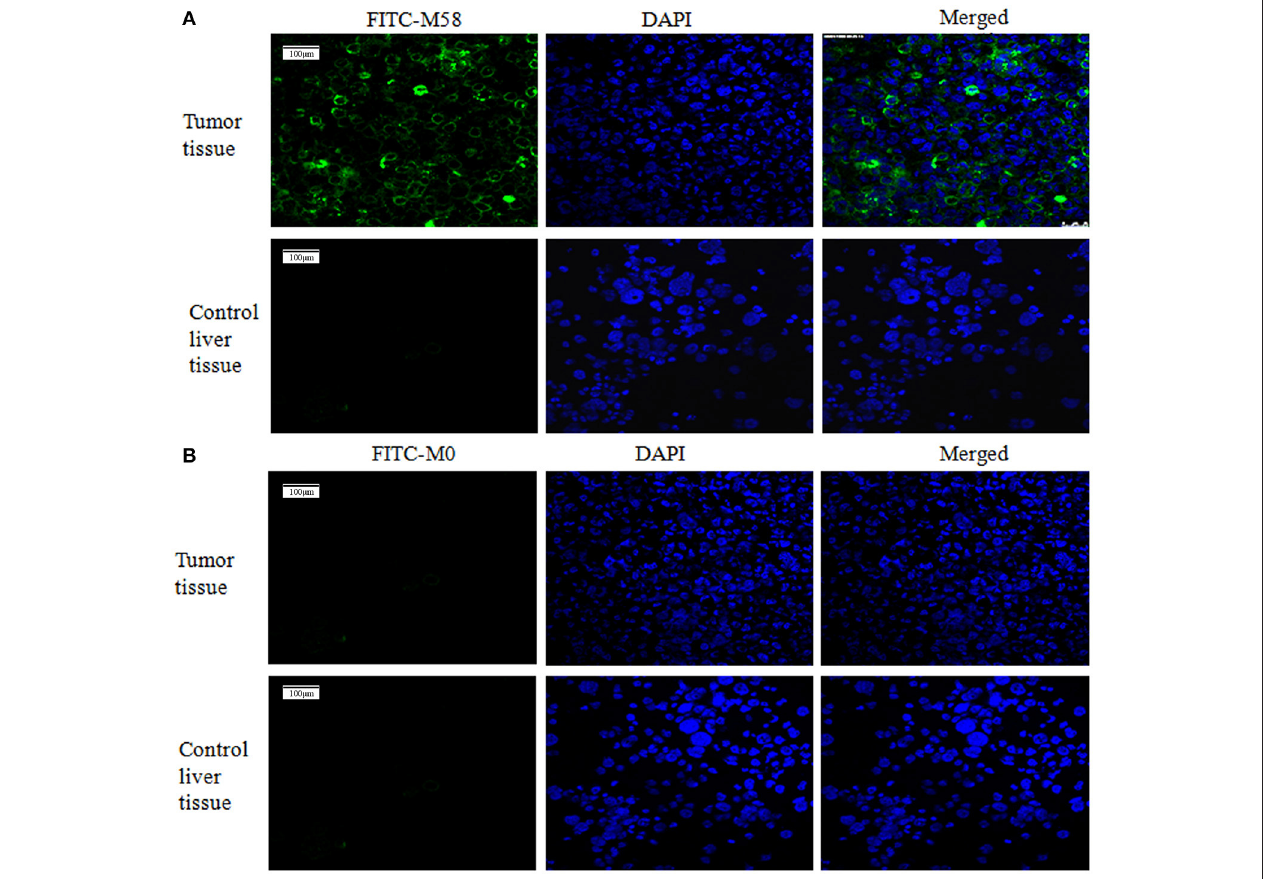
FIGURE 6 | Binding status of polypeptide M58 in the nude BALB/c mice. (A) Polypeptide M58 labeled with fluorescein isothiocyanate (FITC) was observed to specifically bind to tumor tissue, but not to control liver tissue. (B) The FITC-labeled control polypeptide M0 was observed to bind to neither tumor tissue nor control liver